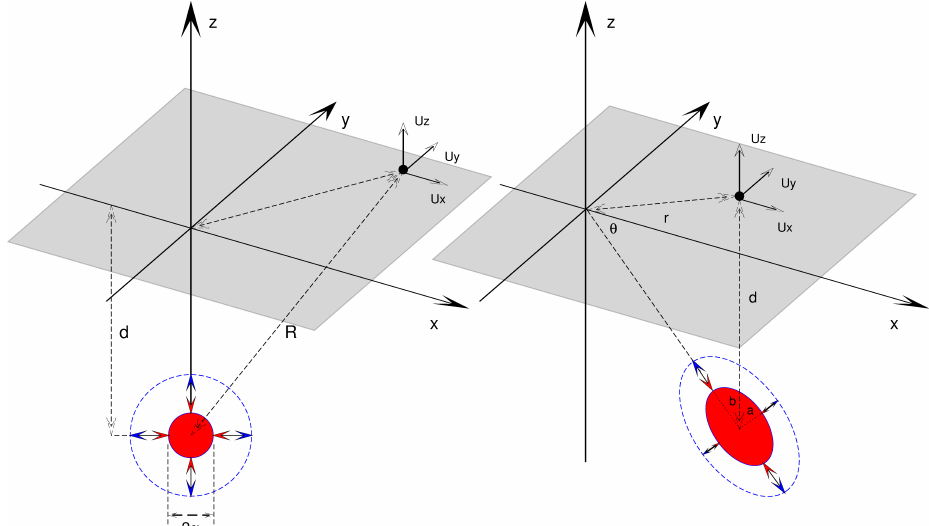
Figure 1. Schematic diagrams of the Mogi ( left ) and the Yang ( right )